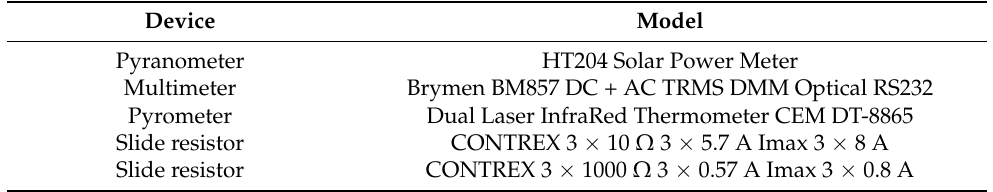
Table 2. List of devices